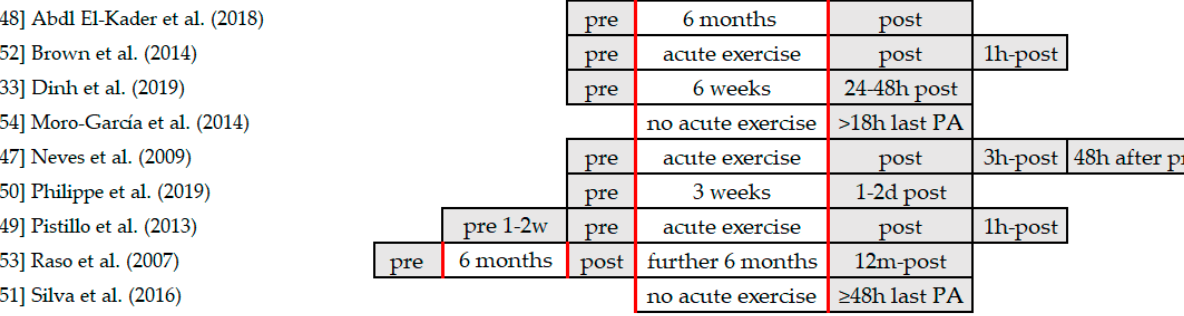
Figure 3. Scheme of time when blood samples were taken in connection with the time exercise intervention took place. Blood samples were taken pre-intervention and post-intervention, highlighted in grey. Moro-García et al. [54] and Silva et al. [51] investigated retrospectively and therefore only took one blood sample. In the other studies, there was at least one examination pre-exercise and post-exercise. Training periods are marked in red and highlighted in white. d: day(s); h: hour(s); m: months; PA: physical activity; w: week(s).